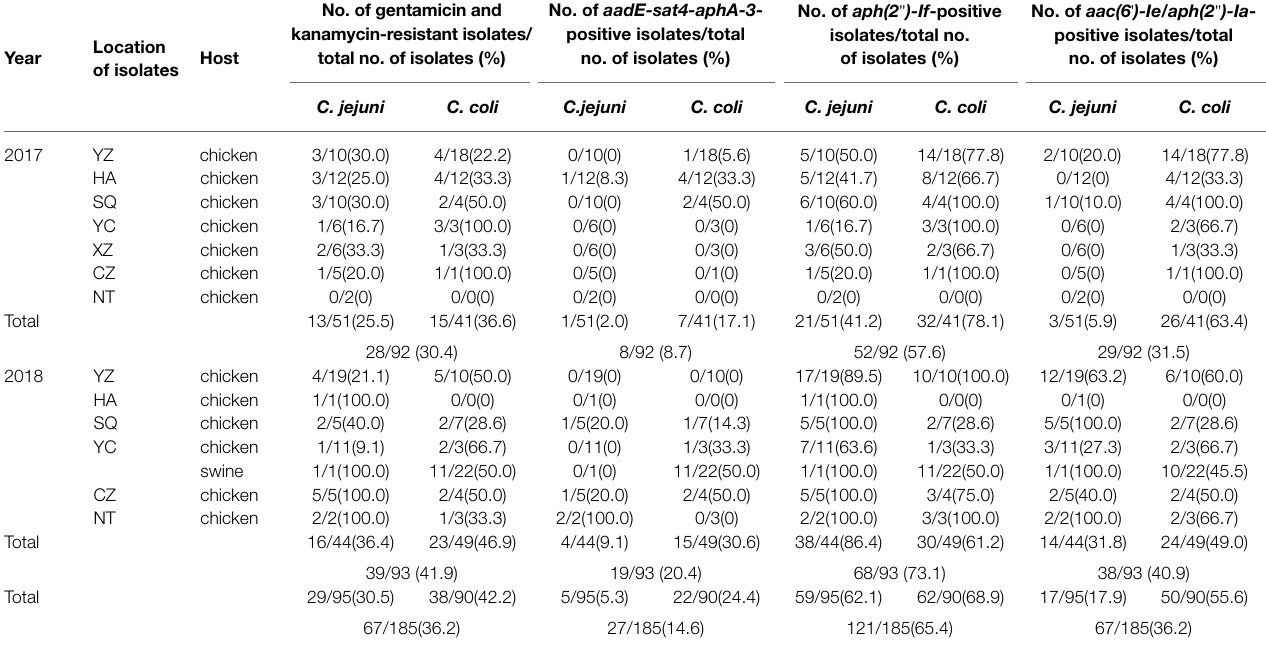
TABLE 2 | Prevalence of gentamicin and kanamycin resistance and the associated resistance